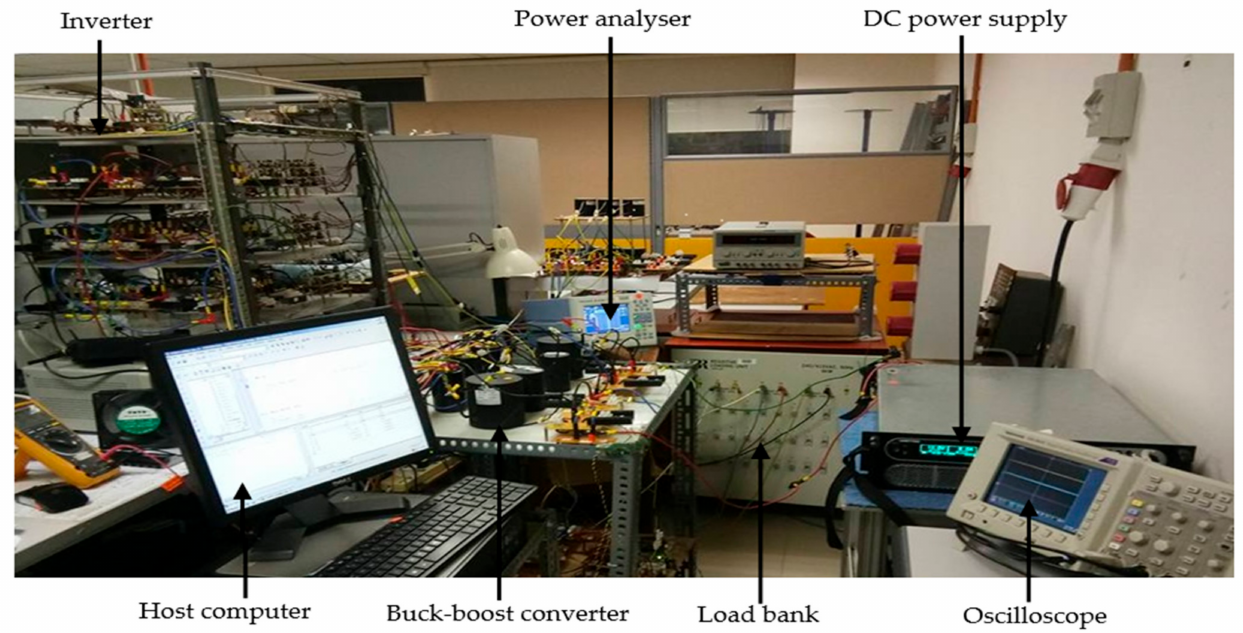
Figure 12. Photo of experimental setup to investigate capacitor voltage balancing